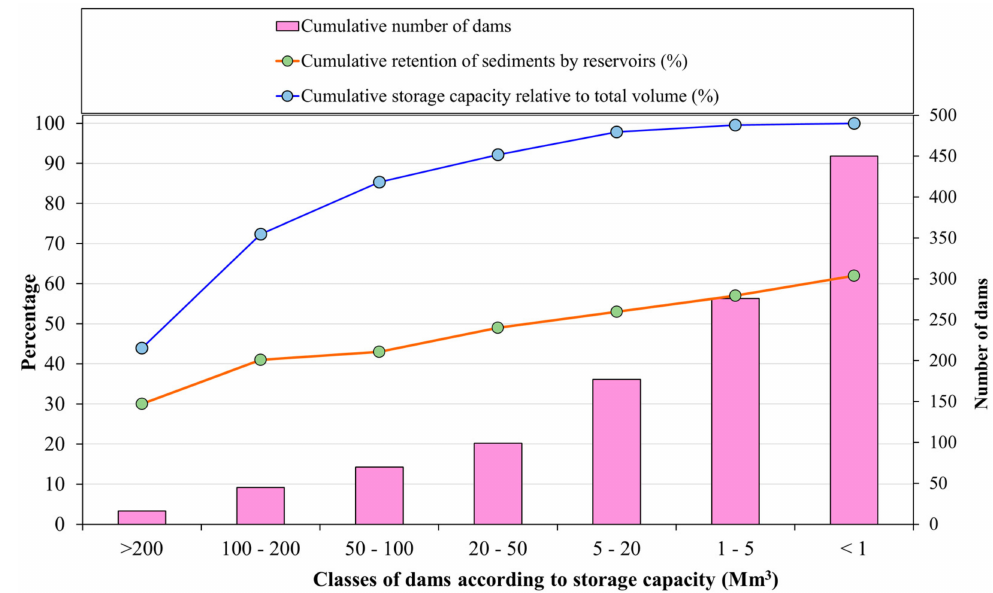
Figure 5. Cumulative reservoir storage capacity (blue line) and sediment retention (orange line) according to various classes of reservoir storage capacities. The cumulative number of dams in each class is shown as well (purple bars). For further explanations, see